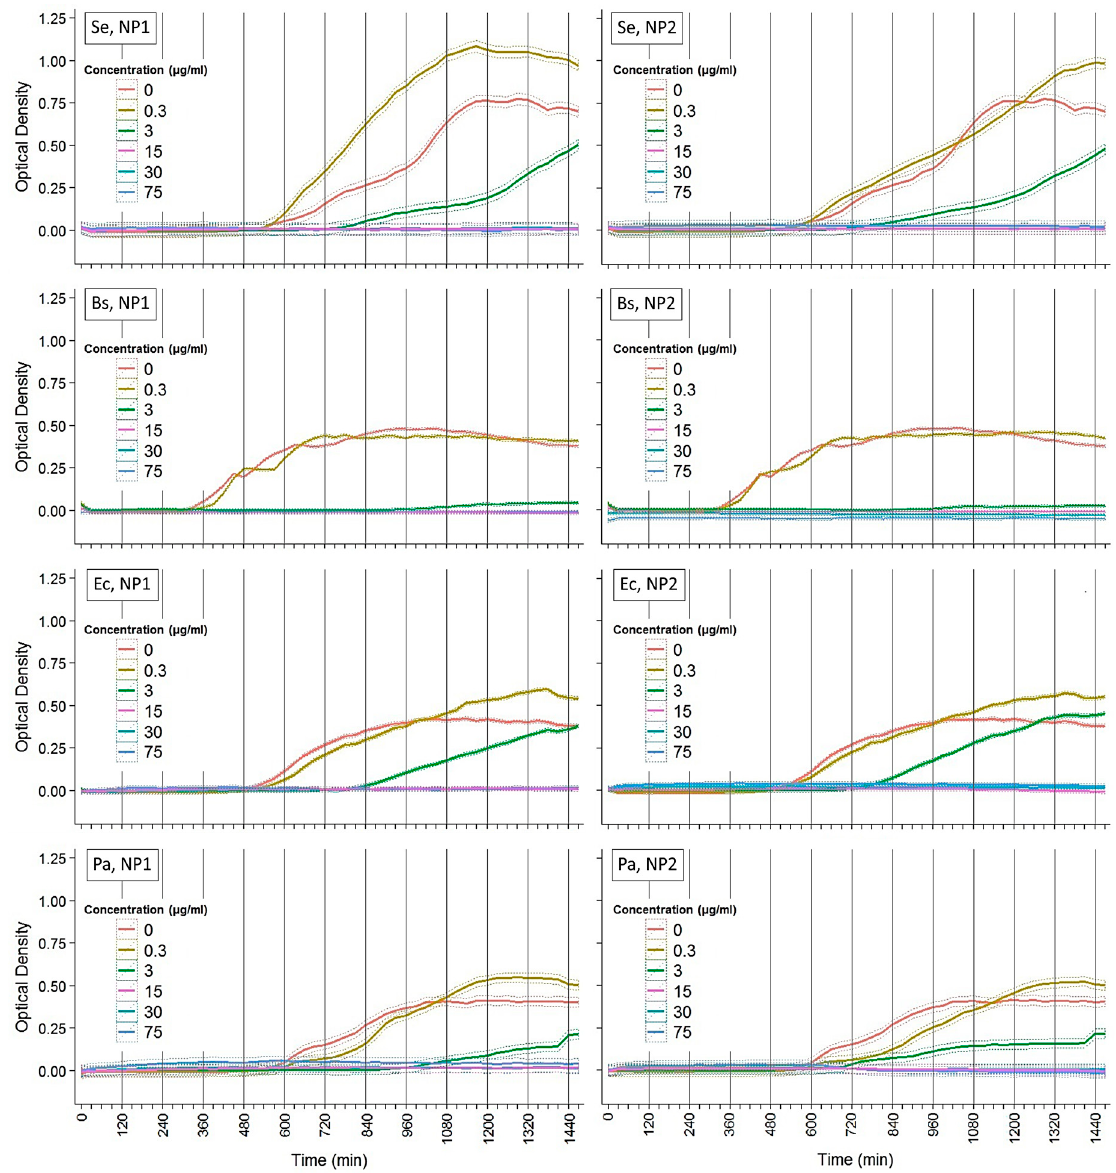
Figure 5. Kinetics of growth of bacterial pathogens under NP antibiosis. Optical densities were measured for 48 h at 37 °C using a multi-detection microplate reader at 600 nm and automatically recorded for each well every 20 min. Ordinary least square estimates and their standard errors calculated by LMMs (see methods) for three independent experiments of quadruplicate data sets are plotted here. Se: S. epidermidis ; Bs: B. subtilis subsp. subtilis ; Ec: E. coli ; Pa: P. aeruginosa . Left panels: variation I NPs (NP1). Right panels: variation II NPs (NP2).